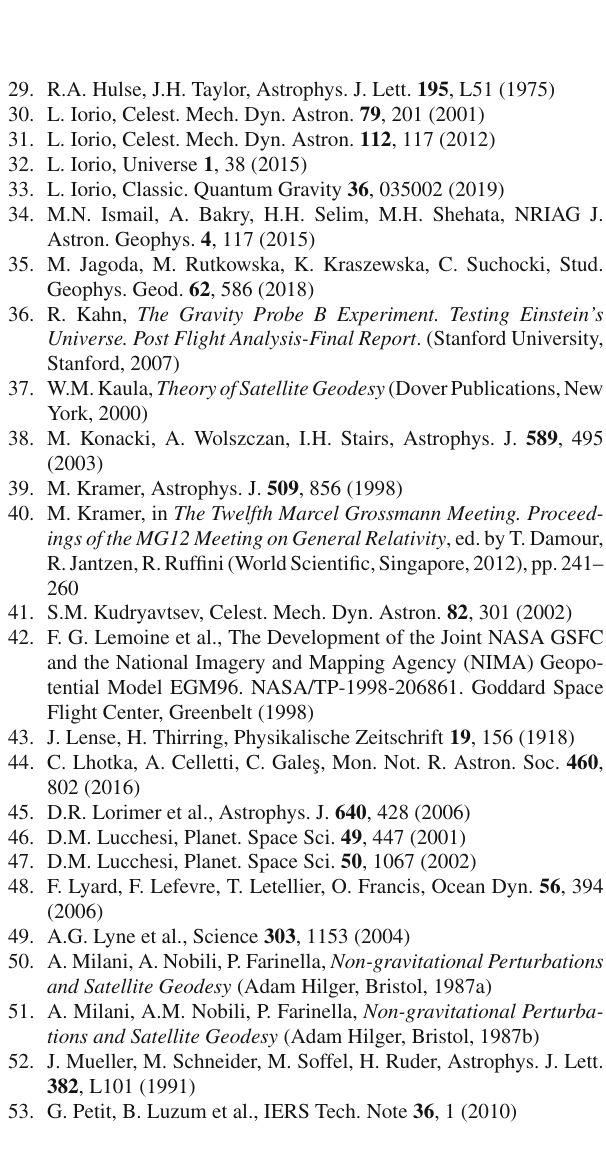
Fig. 5 Mismodeled amplitude, in mas year − 1 , of the rate of change of the satellite’s inclination I induced by the Earth’s magnetic field through the Lorentz force as a function of the semimajor axis a for different values of the satellite’s surface charge | Q | within the range